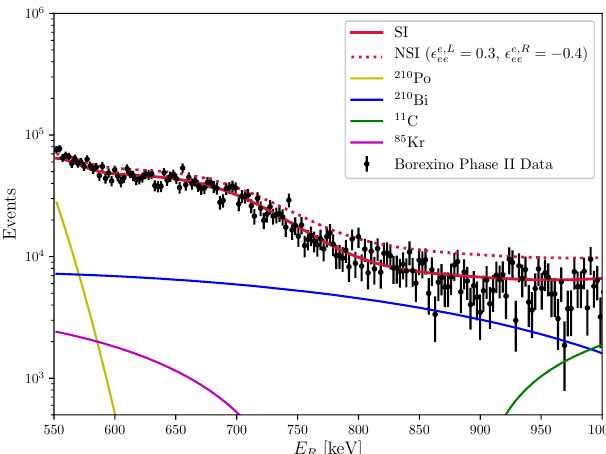
Figure 6 . The solar neutrino spectrum from the Borexino Phase II dataset is shown around the 7 Be compton edge. Data, and information on backgrounds, was obtained from the Borexino data release corresponding to ref. [27] and ref. [56]. Our standard interactions (SI) prediction is shown in solid red. An example NSI solution that enhances the event spectra is shown in dashed